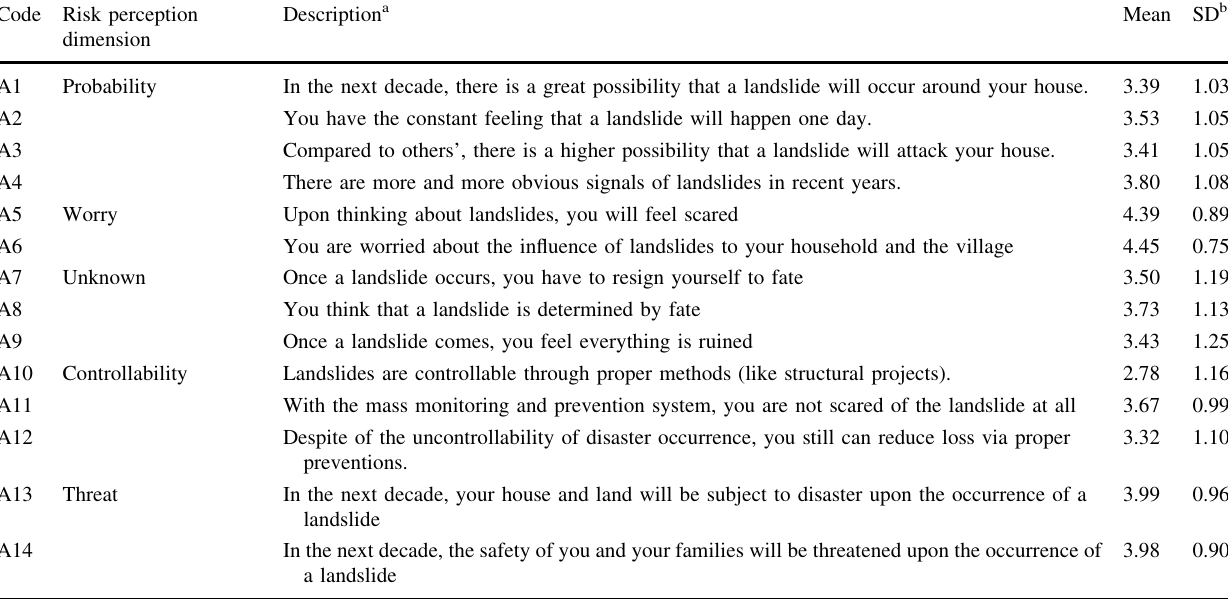
Table 3 Risk perception measurement in the Three Gorges Reservoir study area Code Risk perception Description a dimension